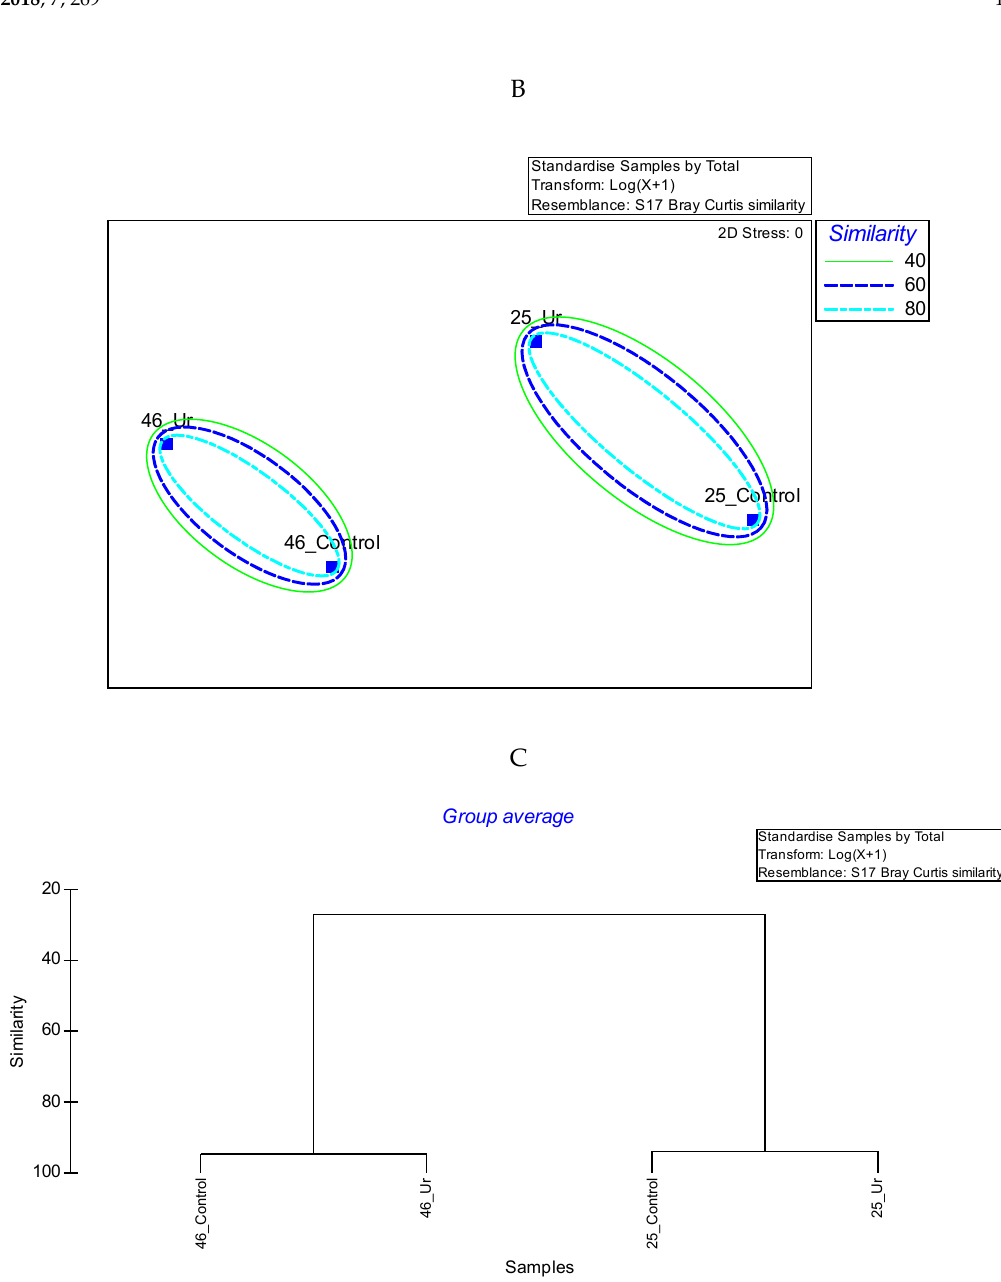
Figure 7. Shown is the heatmap obtained from Burkholderia sp. strains 25 and 46 with top 50 proteins by fold-change from either of the two strains plotted to show their distinctions observed between controls and uranium exposure ( A ). Gradient of fold change is shown by color code, where blue represents the lower most fold change value and red represents the highest fold change value. Parenthesis in yellow and green color represents those proteins that were identified as over-represented in strains 25 and 46; ( B ) Nonmetric multidimensional scaling (NMDS) ordination of all identified proteins from either strain; Bray-Curtis similarity values between are shown at the 40%, 60%, and 80% levels; and ( C ) Dendrogram based cluster analysis of the NMDS of total identified proteins. Data was standardized, transformed by log (X + 1) and resemblance matrix was calculated prior to plotting the NMDS and dendrogram.